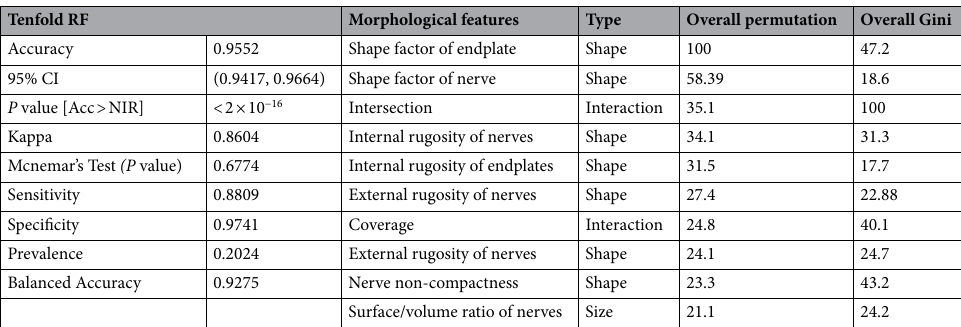
Table 3. Overview of NMJ diagnosed using machine learning.